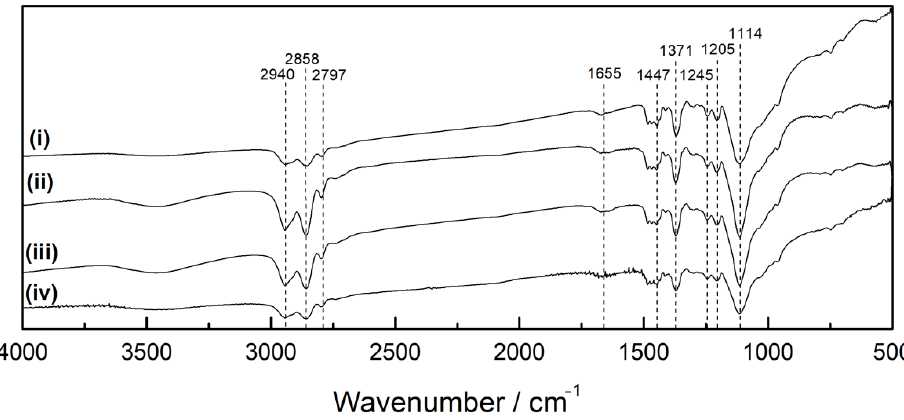
Figure 4. FTIR spectra of A(170)_ 3a OIH sol–gel matrices: (i) A(170)_ 3a @500; (ii) A(170)_ 3a @600; (iii)